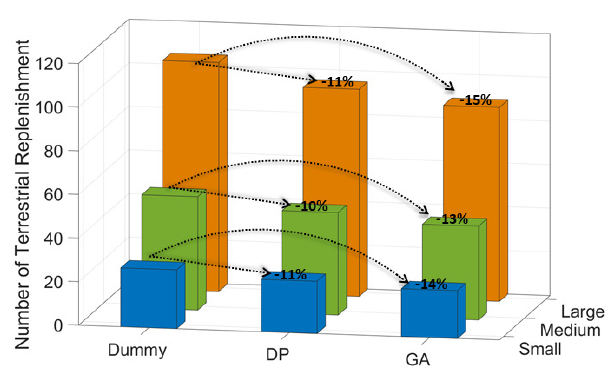
Figure 10. The number of terrestrial ABS replenishment with respect to different approaches under different scenarios is approximately 5%, 9%, and 13% for small, medium, and large scenarios, respectively. Again, GA implementation of the proposed framework has a better performance on average endurance value compared with DP implementation. The superiority of GA implementation versus DP implementation